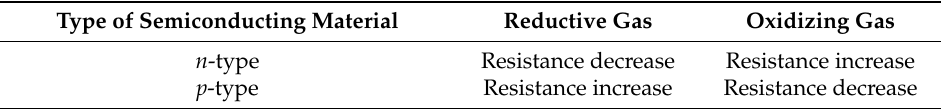
Table 1. Resistance shift in semiconductor material in relation to redox type of target gas.